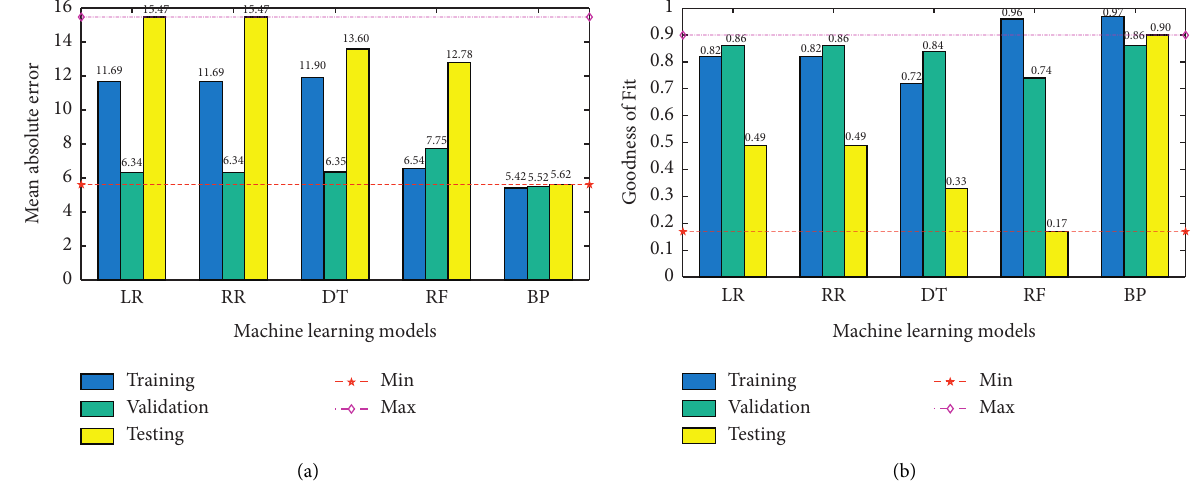
Figure 2: Performance of the models. (a) MAE. (b)